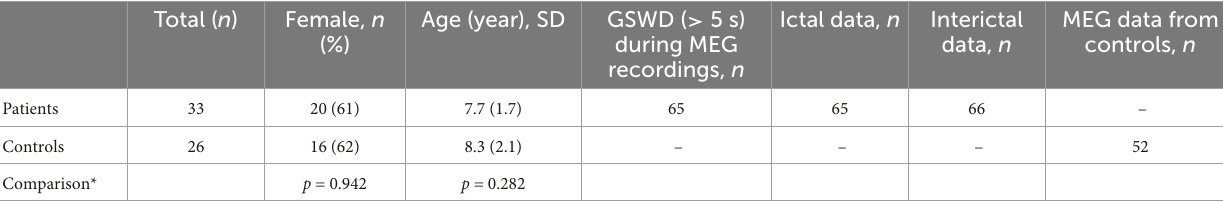
FIGURE1 Study profile.